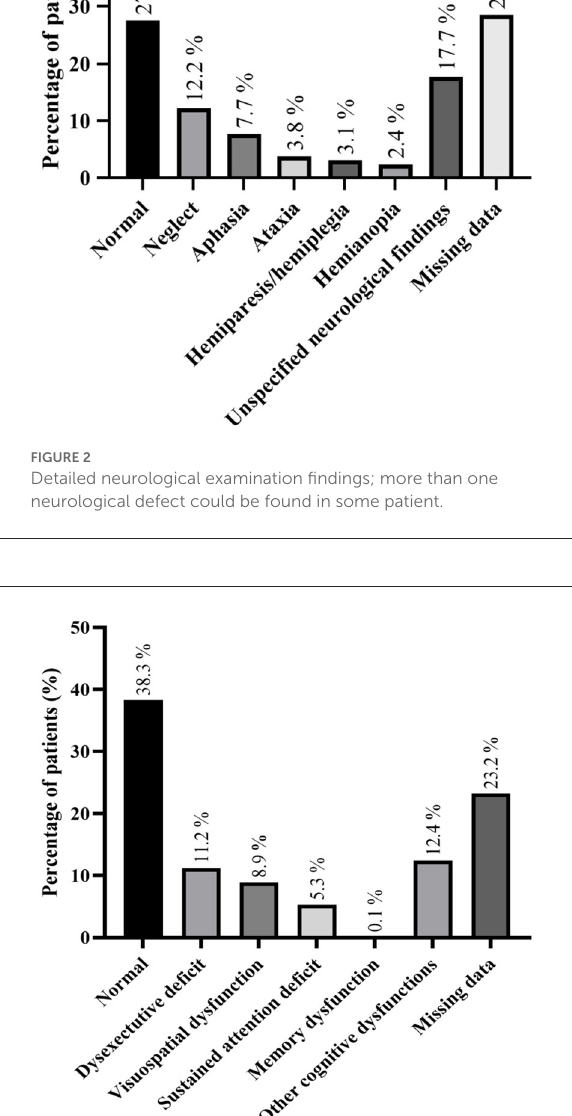
structures (dorsolateral prefrontal cortex (24, 25, 27, 28, 32, 36, 44, 47), parietal cortex (32, 36, 44–47), including supramarginal (26, 28, 33) and angular gyri (28), temporal cortex (26, 32,